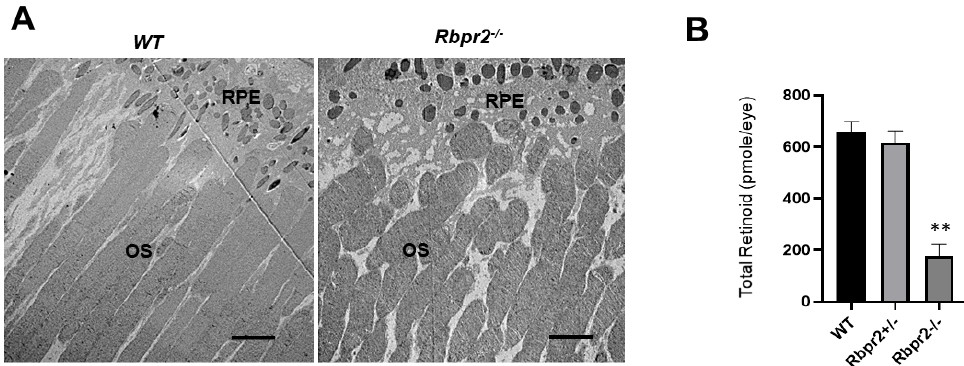
Figure 5. Rbpr2 − / − mice on vitamin A-deficient diets show decreased ocular retinoid concentra- tions and shorter photoreceptor outer segments. ( A ) Ultrastructural analysis of photoreceptors using transmission electron microscopy (TEM): Representative TEM images of photoreceptors from 12-week old WT and Rbpr2 − / − mice on vitamin A-deficient diets are presented. Scale bar = 600 µm. RPE, retinal pigmented epithelium; OS, outer segments. Data are representative of n = 6 retinal sections per eye from n = 4 mice per genotype. ( B ) Quantification of total retinoid concentrations (pmole/eye) in eyes from WT, Rbpr2 +/ − , and Rbpr2 − / − mice (eyes from n = 8 mice per genotype). ** p < 0.005, Rbpr2 − / − compared to controls.